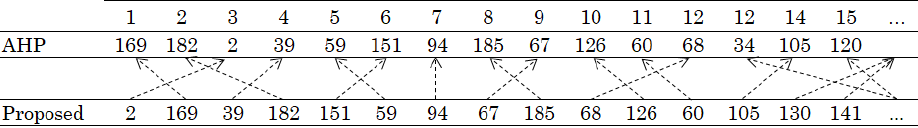
Figure 7. Ranking of the top 15 alternatives using the classical AHP and the proposed scalable approach.